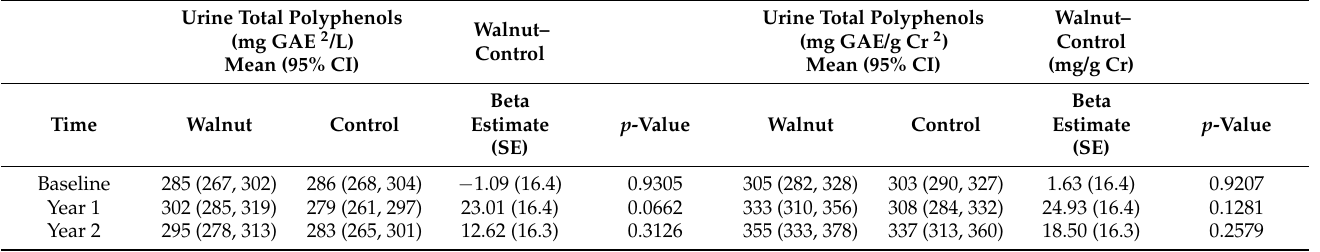
Table 5. Comparison of the morning spot urine polyphenol excretion between treatment groups 1 .